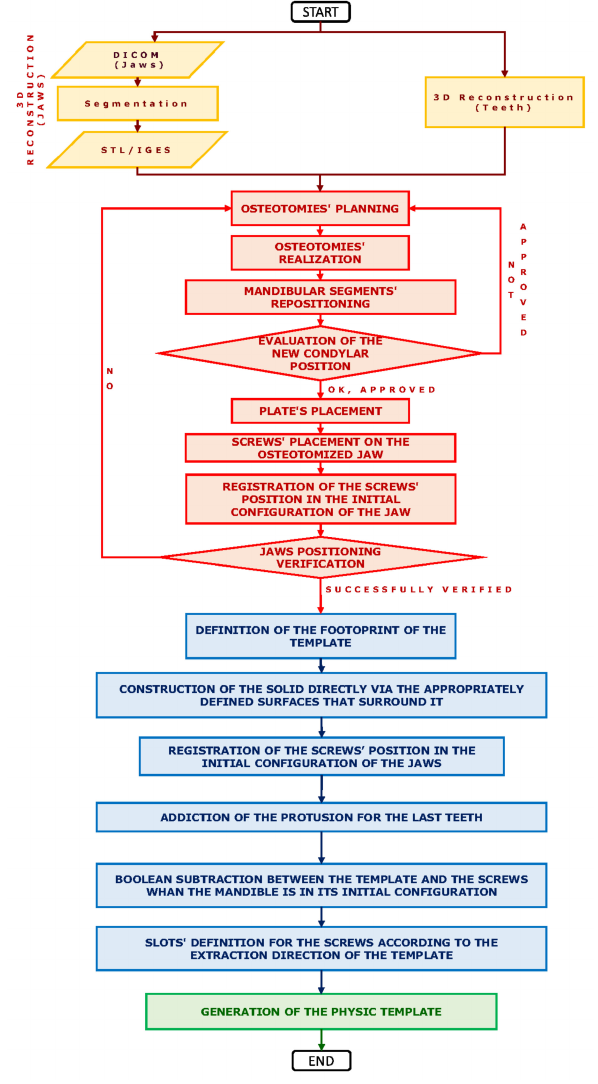
Figure 5. Methodology in form of